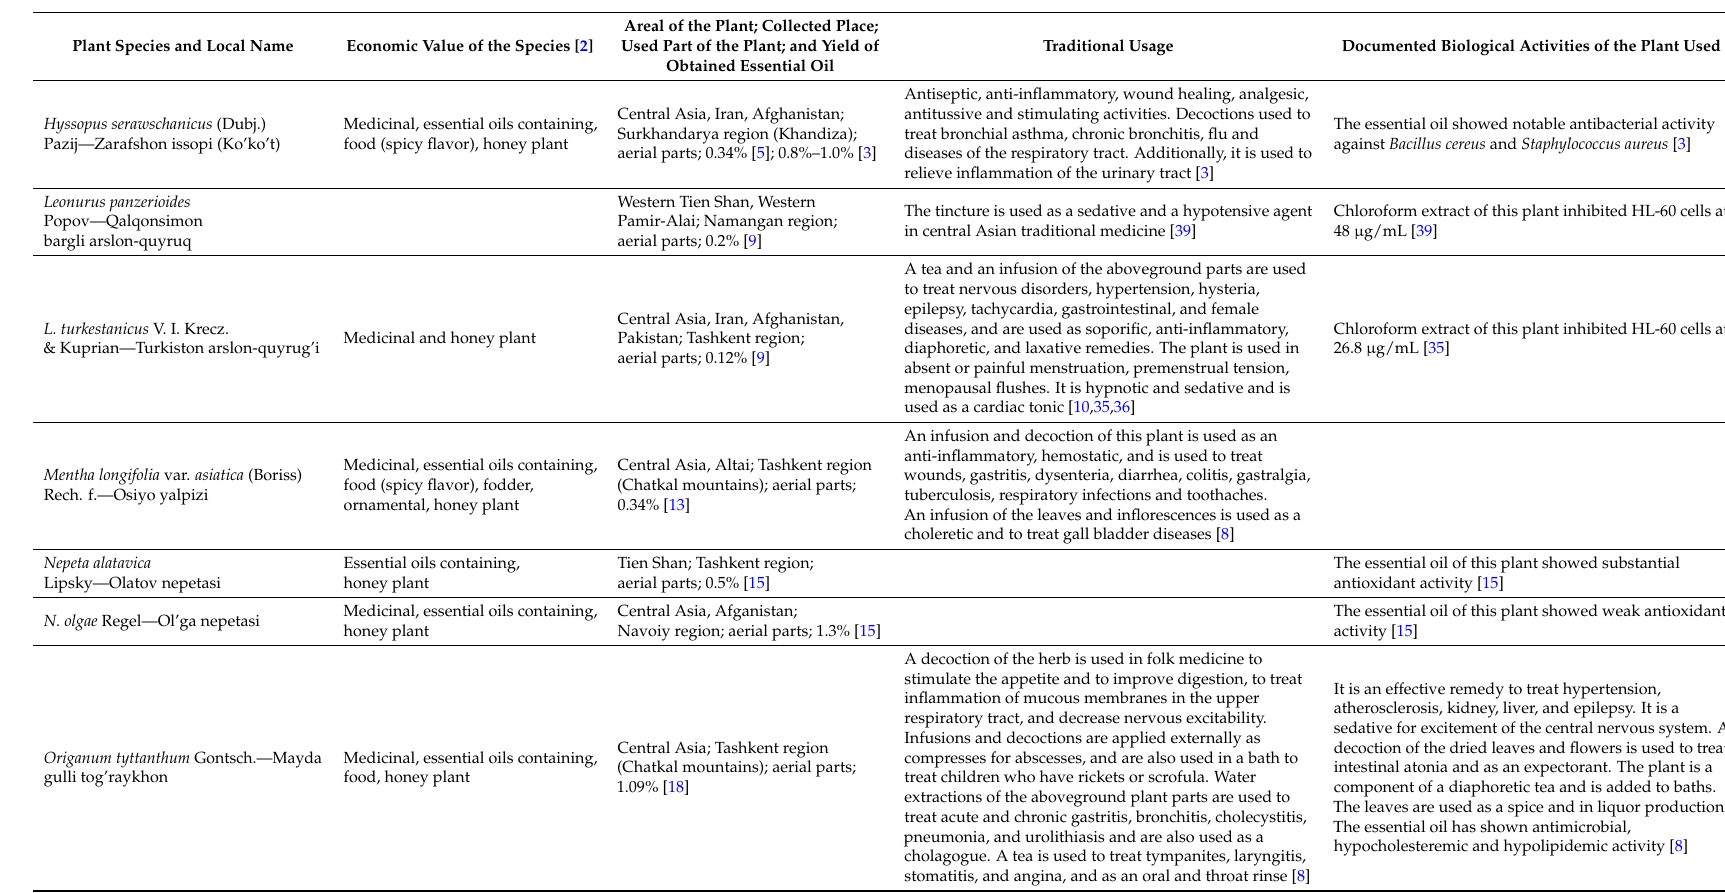
Table 1. Ethnopharmacology and biological activities of Uzbek Lamiaceae family